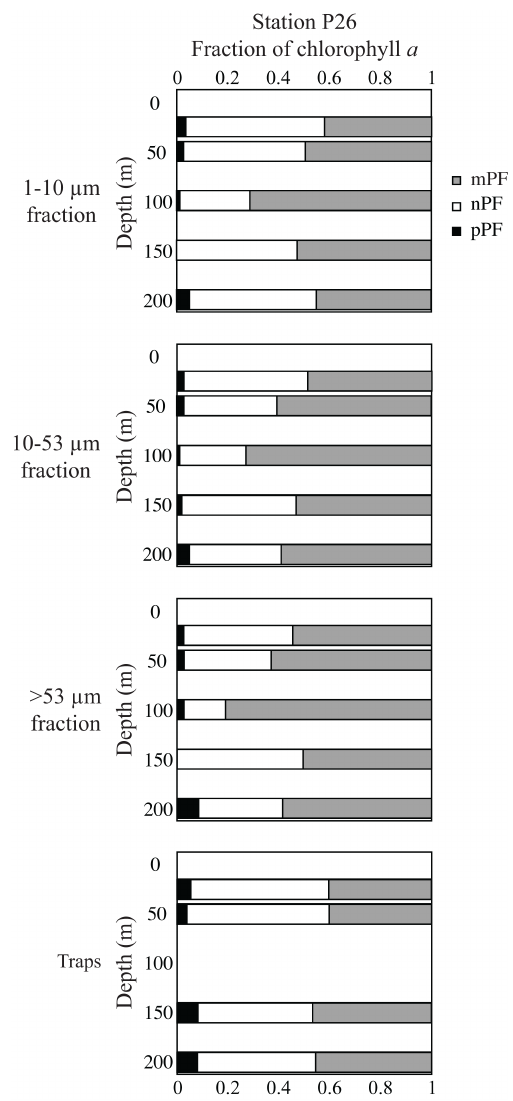
Figure 6. Pigment PFs for each phytoplankton size class plotted as a function of sample depth and particle size class at stations sam- pled on Line P in June 2011. Size-fractionated data are pump data. Sediment trap PFs are also